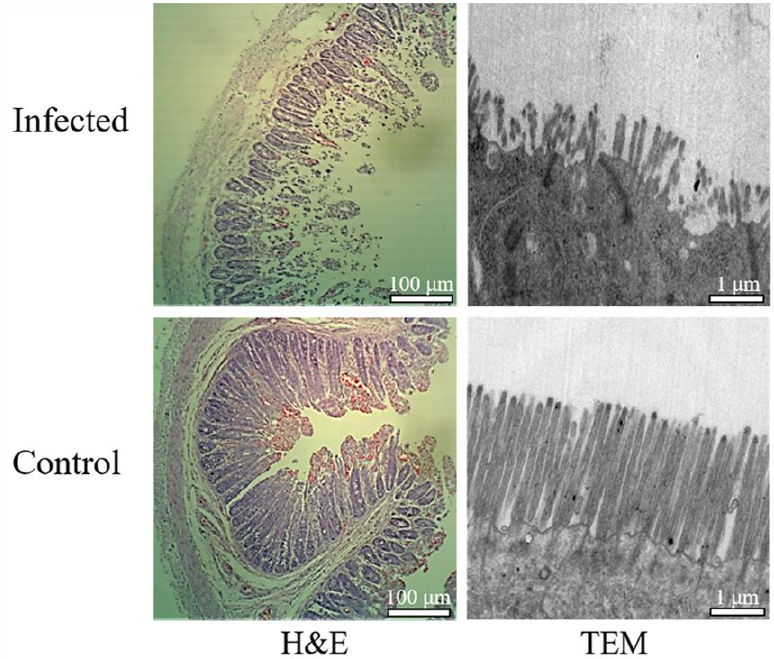
Figure 1. Histopathological analyses of the jejunum tissues derived from porcine epidemic diarrhea virus (PEDV)-infected and control animals. H&E: hematoxylin and eosin staining, TEM: Transmission electron microscopic.